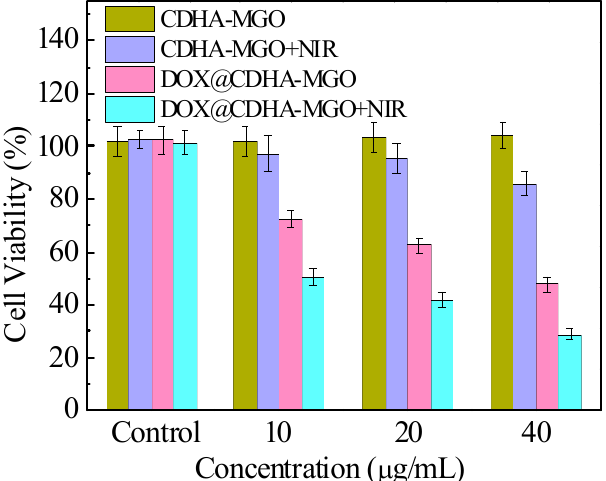
Figure 8. In vitro cytotoxicity of CDHA–MGO and DOX@CDHA–MGO in the presence or absence of NIR irradiation at 2 W · cm − 2 for 5 min, as measured in terms of cell viability.